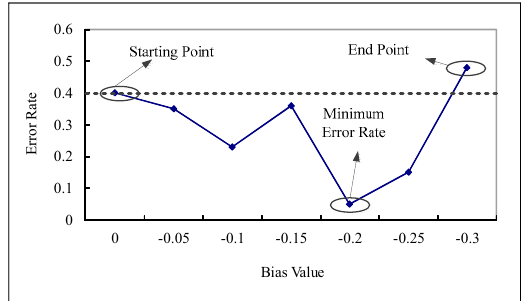
Figure 4. Bias determination: the horizontal axis denotes the bias increment; the vertical one denotes the resulting error rate.